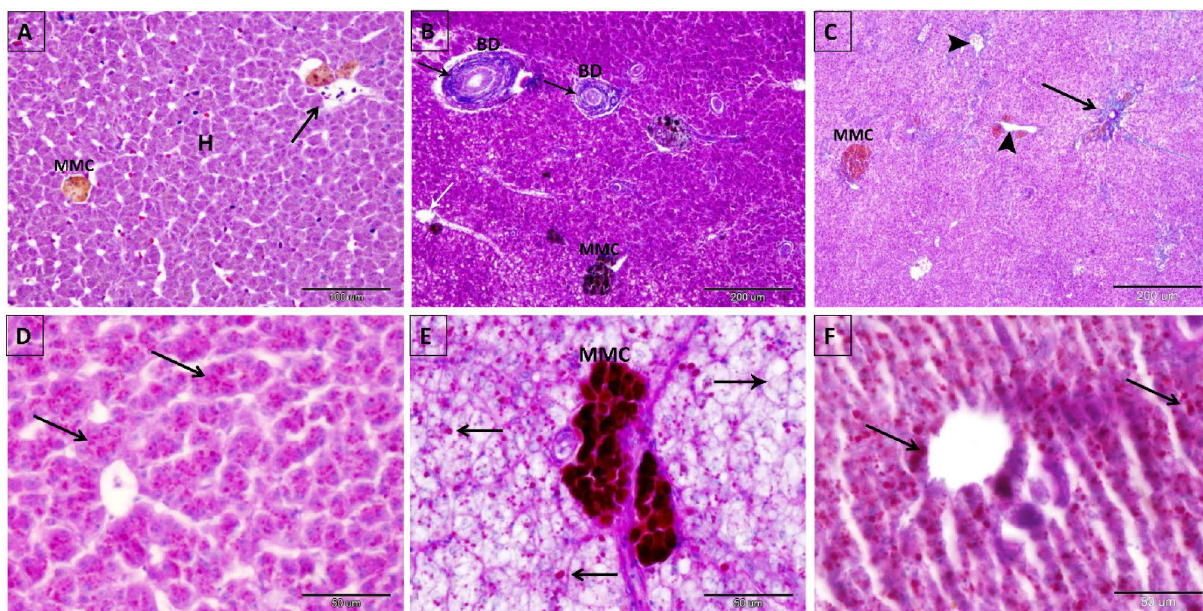
Figure 4. Photomicrograph of paraffin sections in the liver of control, 4-NP-intoxicated, and 2.5% NSS treated groups. ( A , D ) Liver of control Clarias gariepinus . ( A ) Displaying normal hepatic structure and hepatocytes (H) and minimal connective tissue around the central veins (Arrow), ( D ) Showing the presence of numerous fine PAS-positive glycogen granules in the cytoplasm of hepatocytes. ( B , E ) Liver of 4-NP-intoxicated Clarias gariepinus . ( B ) Showing proliferation of connective tissue around the bile ductule (BD) (sclerosing cholangitis) in the portal area (black arrow) and around the central veins (white arrow). ( E ) Demonstrating fatty change (macrovesicular steatosis) of hepatocytes with depletion in the PAS-positive glycogen granules (arrow). Note the PAS-positive MMCs. ( C , F ) Liver of 2.5% NSS treated Clarias gariepinus . C: Showing partial decrease in the amount of connective tissue in the portal area (arrow) and around the central veins (arrowheads) compared to 4-NP-treated Clarias gariepinus . ( F ) Showing hepatocytes partially restored PAS-positive glycogen granules in the cytoplasm (arrow). Scale bar in ( A ) = 100 μm; ( B , C ) = 200 μm; ( D , E ), F = 50 μm. ( A – C ) were stained with Crossmon’strichrome stain. ( D – F ) stained with periodic acid Schiff reagent (PAS) and Hematoxylin stain.